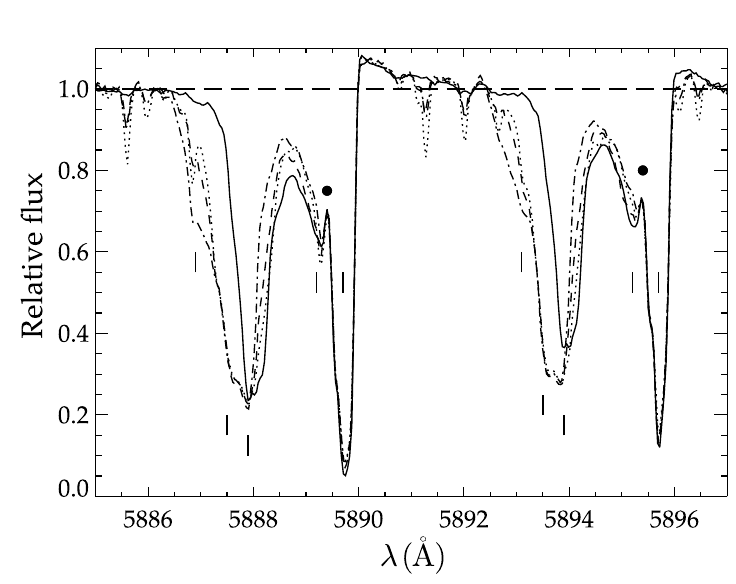
Fig. 3. The changes in the Na ID doublet. The positions of the components, derived by the Gaussian decomposition, are indicated by vertical ticks and listed in Table 4. Dots indicate the local emission peaks with constant wavelength and